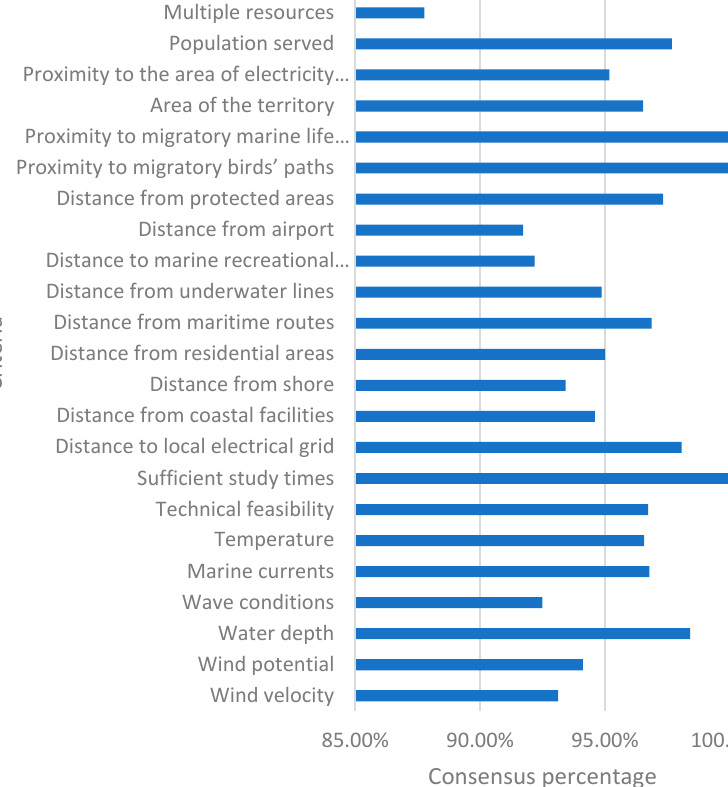
Table 8. Criteria relative importance in the different sensitivity analysis